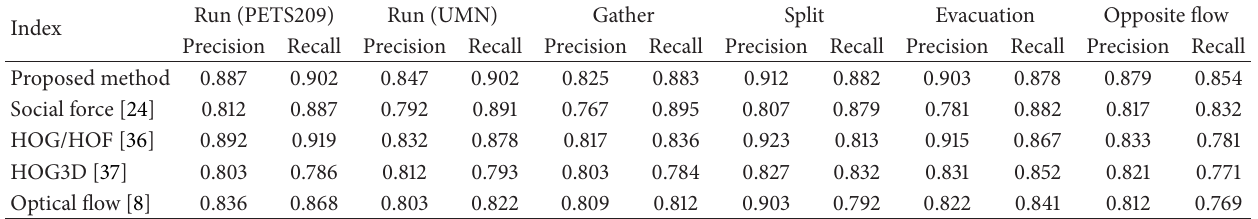
Table 1: Comparison of precision and recall for different algorithms.